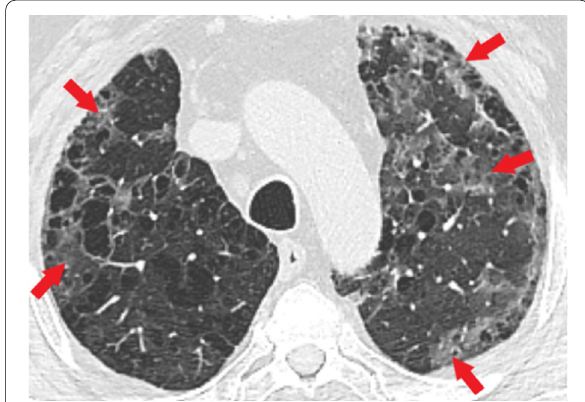
Fig. 1 A 71-year-old man in the COPD group. Axial CT image at the level of upper lobes shows bilateral distribution of peripheral and subpleural predominant GGO (red arrows) in the background of paraseptal and centrilobular emphysema. COPD—chronic obstructive pulmonary disease ; CT—computed tomography; GGO— ground-glass